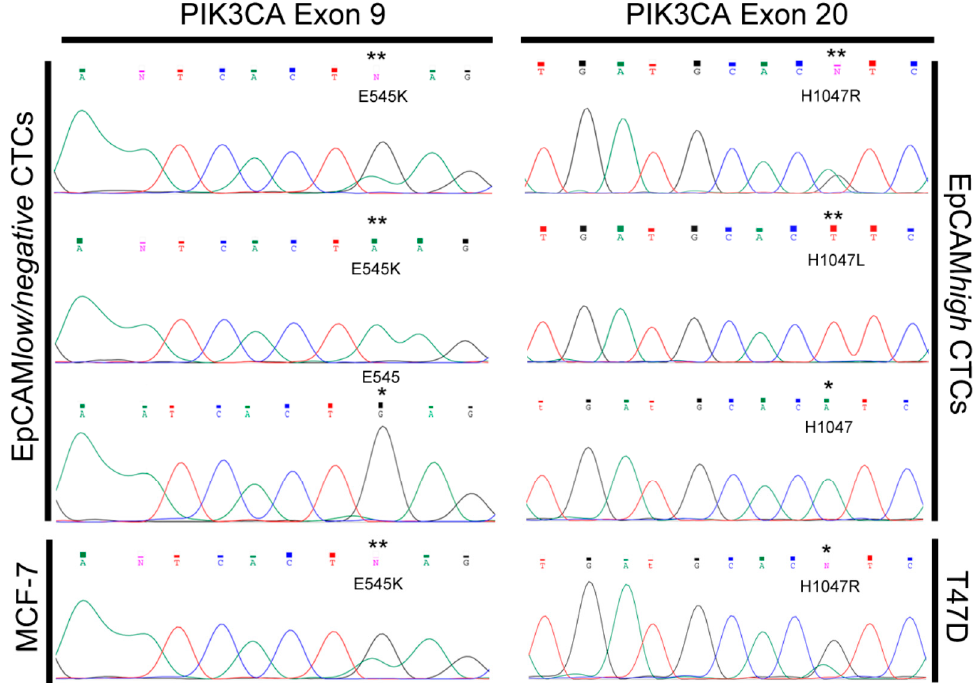
Figure 5. PIK3CA Exons 9 and 20 sequencing profiles. Single circulating tumor cells (CTCs) collected from four different patients and sequenced for PIK3CA exon 9 and exon 20 show Phosphatidylinositol 3-kinase catalytic subunit alpha (PIK3CA) hotspot mutations. Two EpCAM low/negative CTCs from 2 different patients exhibit the mutation 9/E545K ( ** ) when compared to the sequencing profile of a single MCF-7 cell ( ** ). Two EpCAM high CTCs from different patients show the mutations 20/H1047R and the 20/H1047L ( ** ) when compared to the sequencing profile of a single T47D cell ( ** ). CTCs recorded as PIK3CA wild-type show no mutations ( * ). ** : base exchange; * wild-type base. Patient I carried PIK3CA hotspot mutations in the EpCAM low/negative CTC group only. The mutation E545K (codon 545 of the exon 9, glutamine to lysine) could be observed in one out of ten analyzed CTCs. The remaining 9 EpCAM low/negative and 2 patient-matched EpCAM high CTCs carried the WT form of the